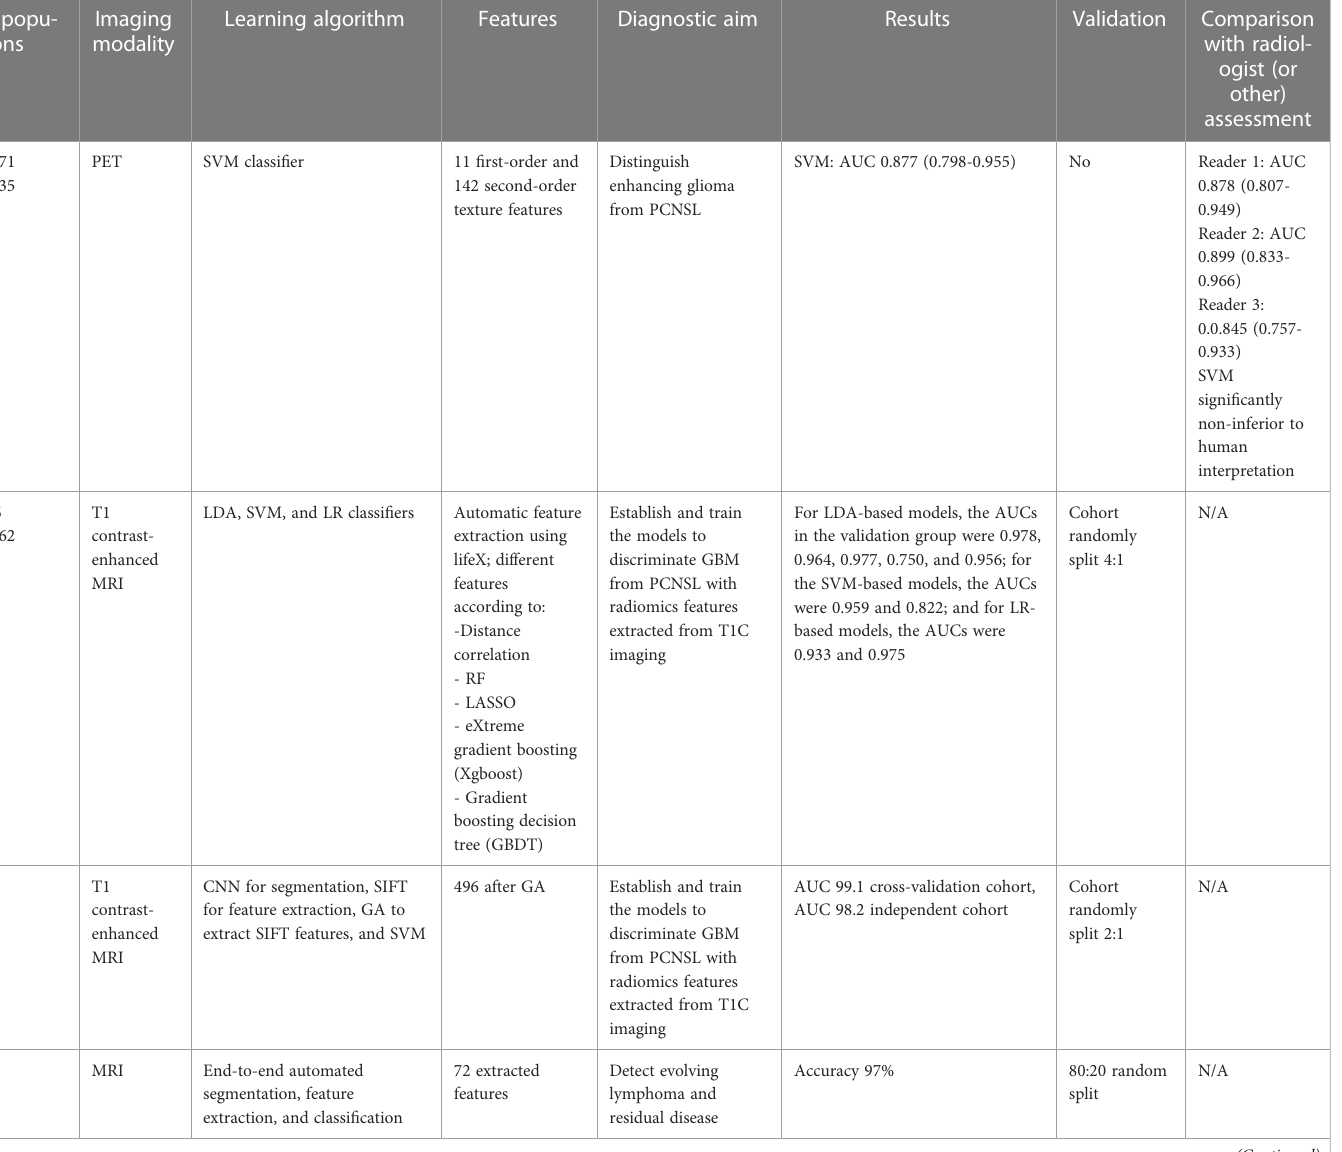
TABLE 1 Studies applying machine learning to the diagnosis of lymphoma or to distinguish it from another